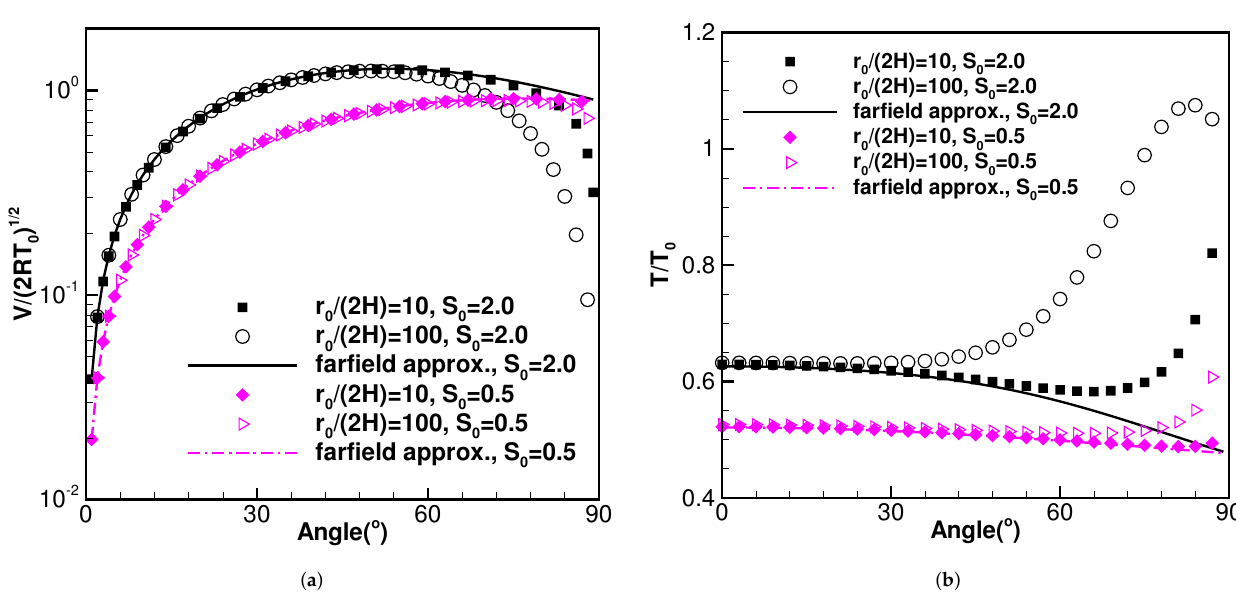
Figure 3. ( a ) Normalized farfield V-velocity component profiles, V 1 ( X , Y ) √ ( X , Y ) files, T 1 T